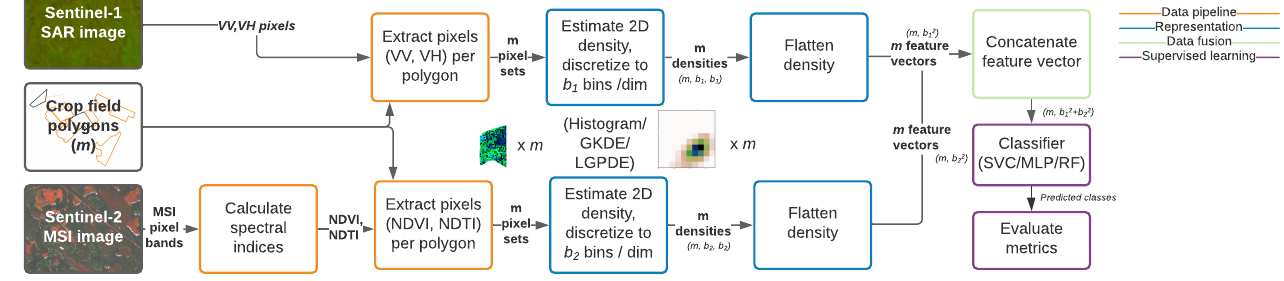
Figure 3. Process diagram with data flow from left to